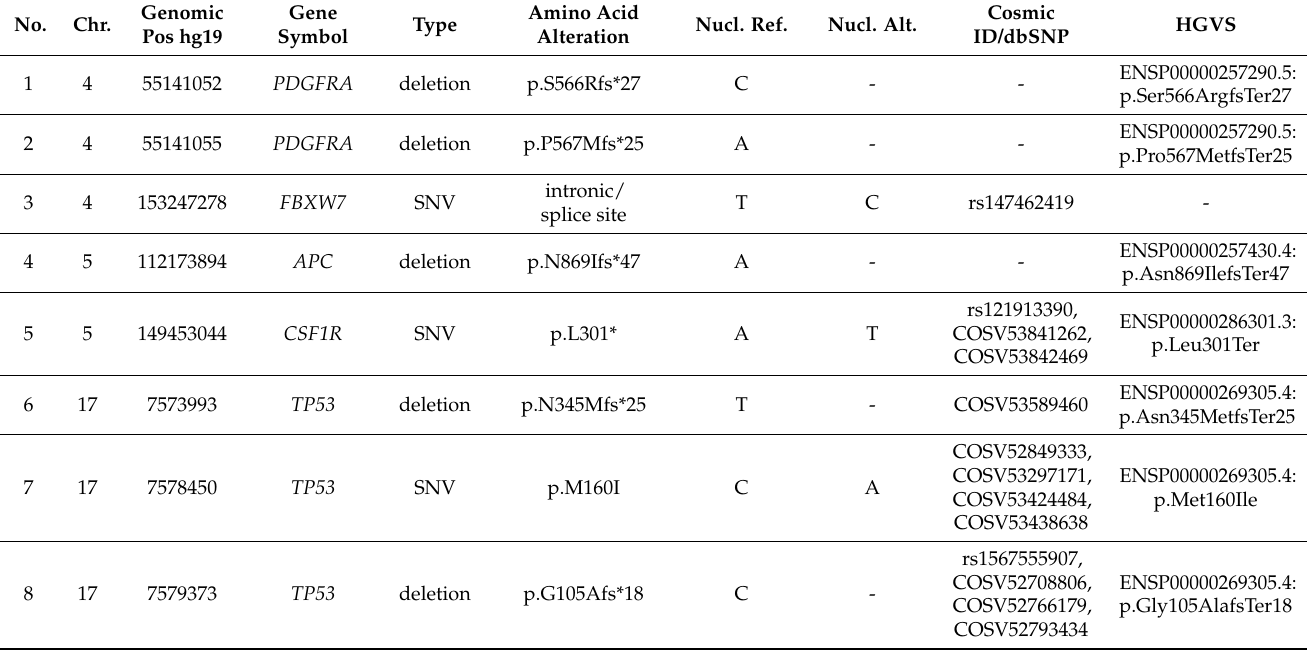
Table 1. Identified somatic variants in a primary melanoma tumor.